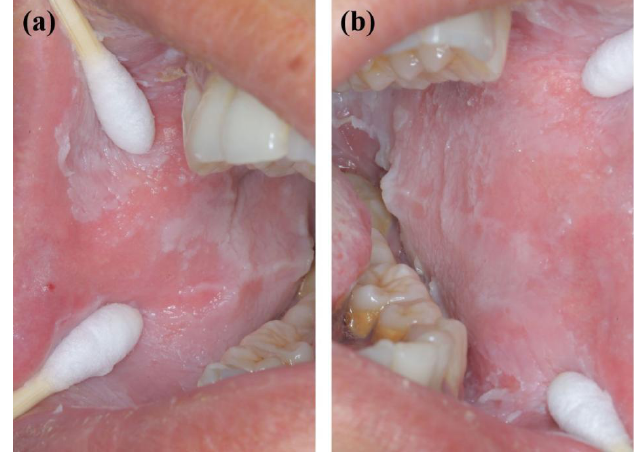
Figure 2. Oral manifestations of the father showing large gray and white folds and plaques in the right ( a ) and left ( b ) buccal mucosa.